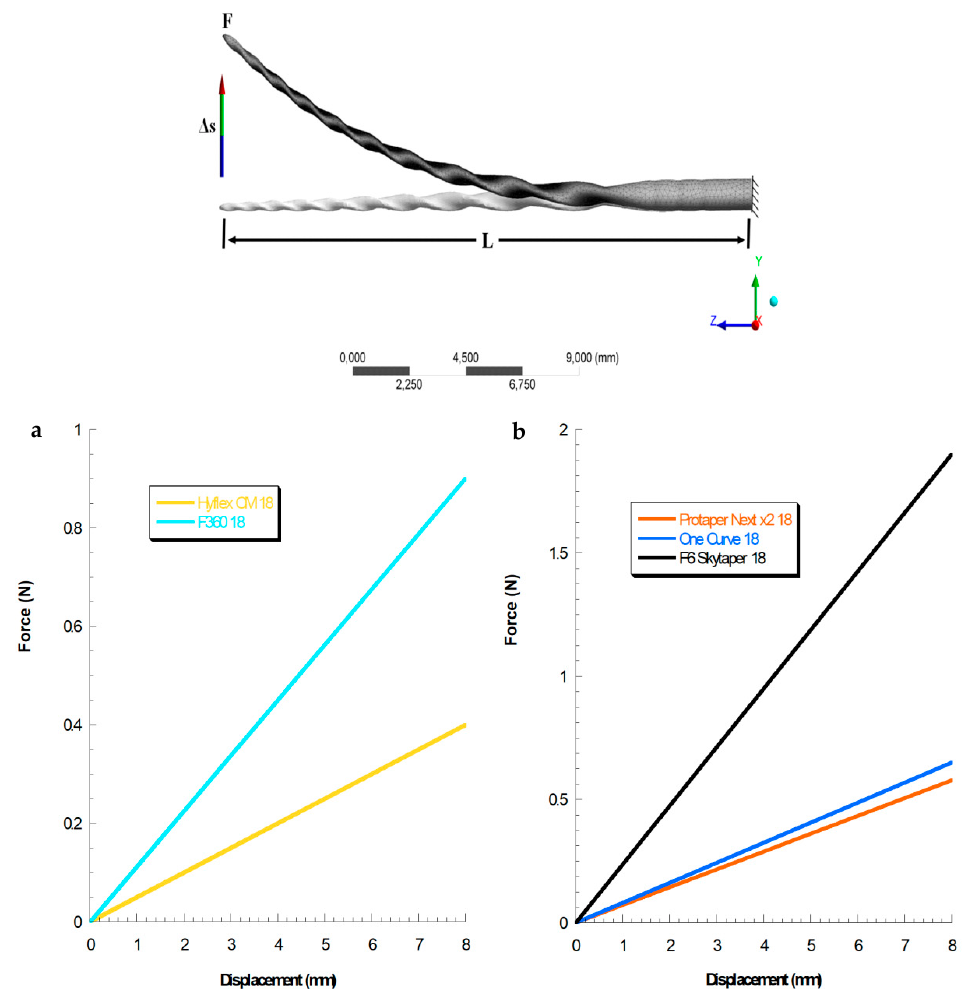
Figure 2. Reaction force in bending condition (flexibility) calculated for each instrument during the insertion into the canal. ( a ) Instruments with 4% conicity. ( b ) Instruments with 6% conicity.